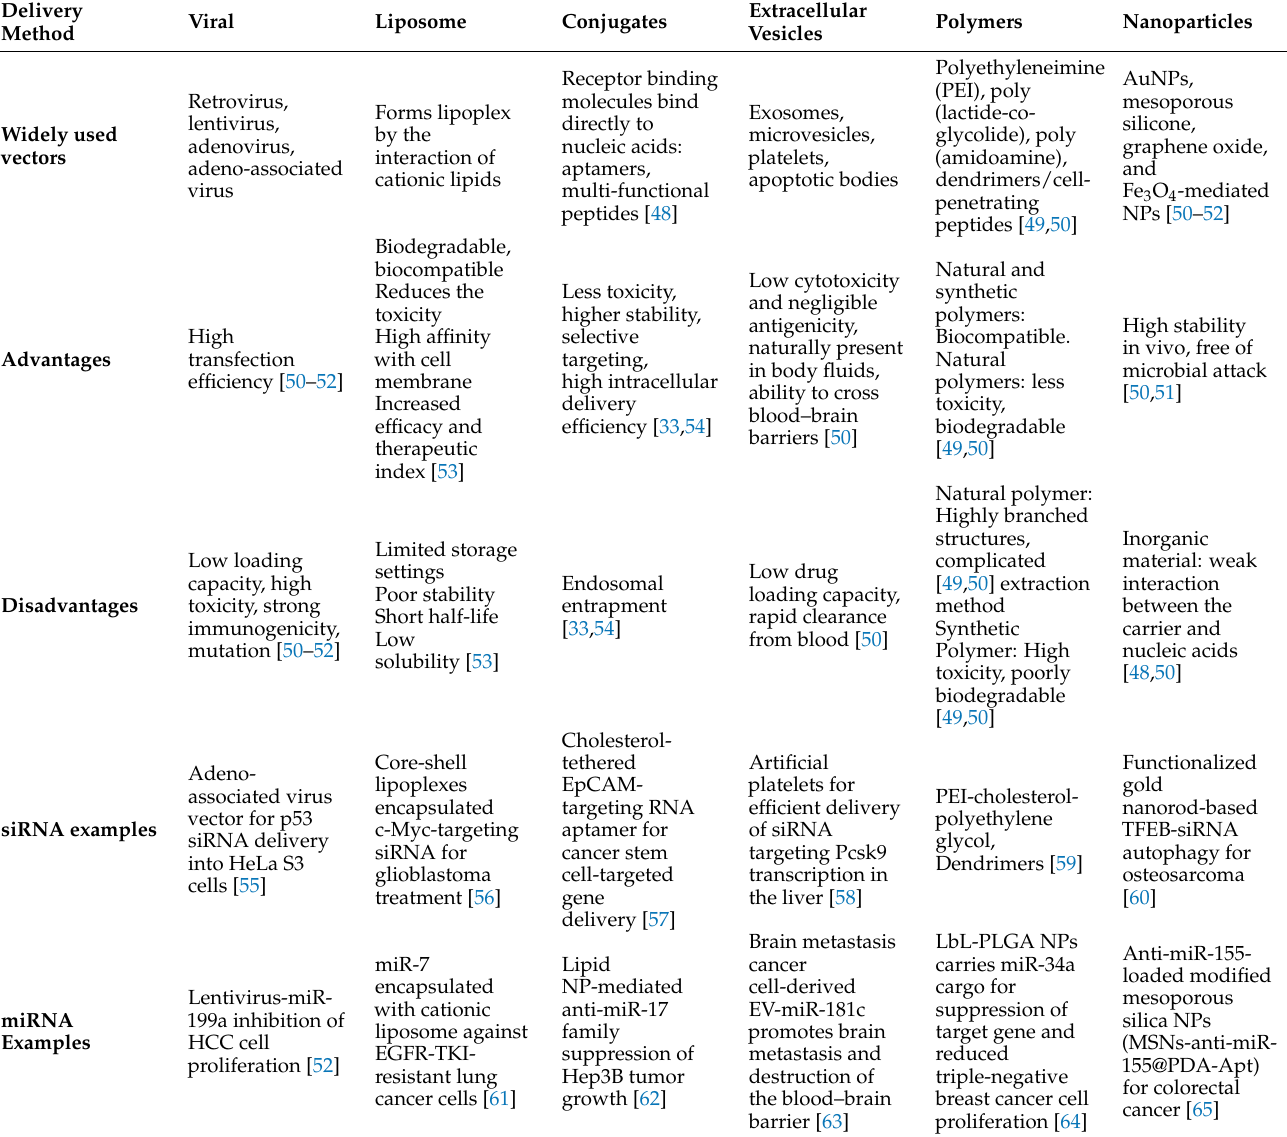
Table 1. A comparison of the potential delivery strategies for miRNA- and siRNA-based